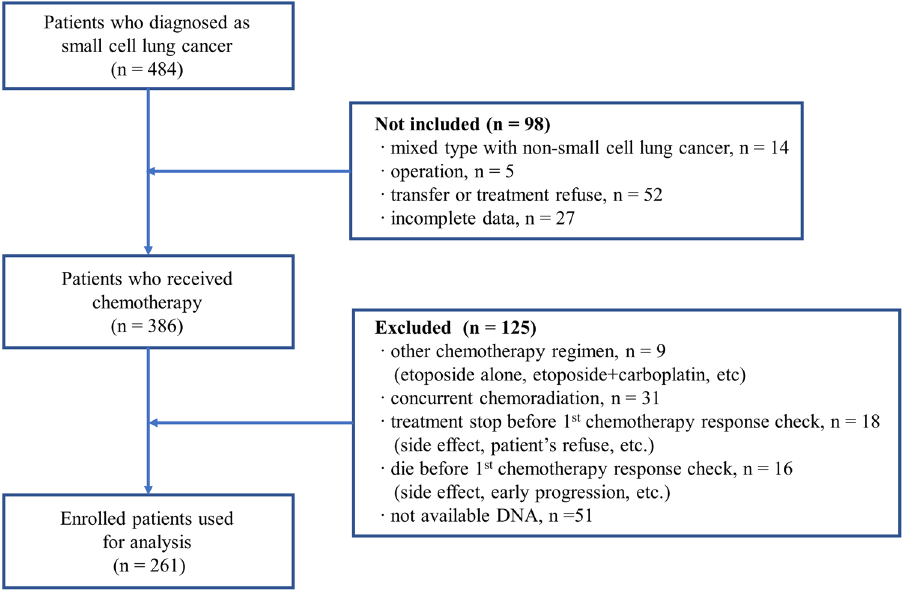
Figure 1. Flow diagram of patients